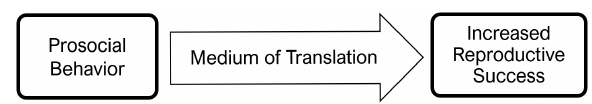
FIGURE 2 | The backchannel : The backchannel model can explain both prosocial behavior (altruism) and the development of a medium of translating past action into reproductive success. This translation has two aspects: the transformation of knowledge of past actions into an image (see Figure 5 ) and the development of the technical part of the backchannel: the transmission of the information about past actions over time and space (from display of natural signs to linguistic communication; see Figure 4 ).